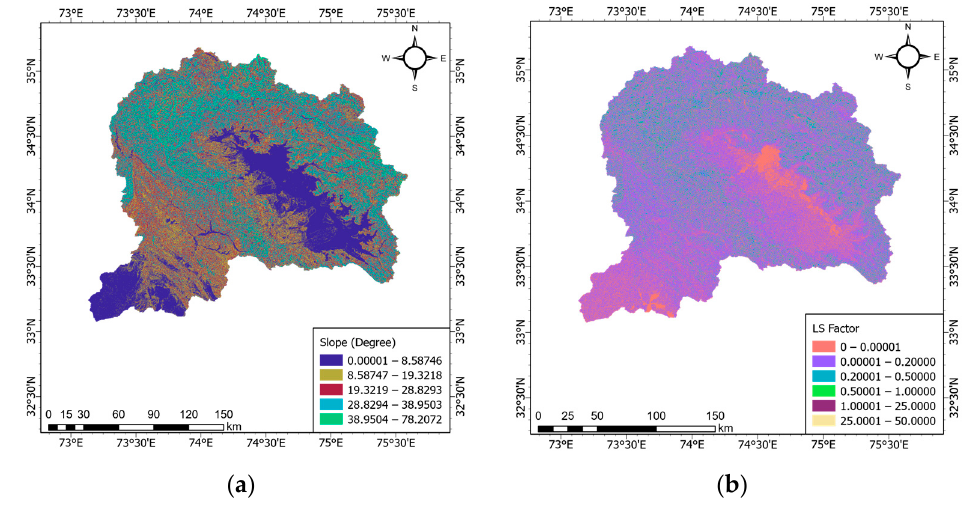
Figure 5. ( a ) Slope Classification Map; ( b ) LS-factor Map.